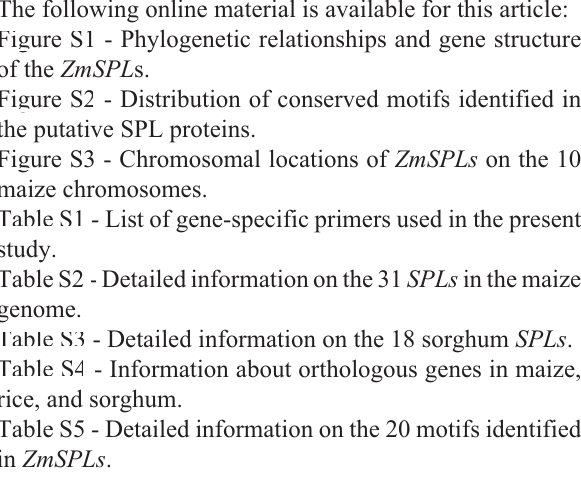
Figure S1 - Phylogenetic relationships and gene structure of the ZmSPL s. Figure S2 - Distribution of conserved motifs identified in the putative SPL proteins. Figure S3 - Chromosomal locations of ZmSPLs on the 10 maize